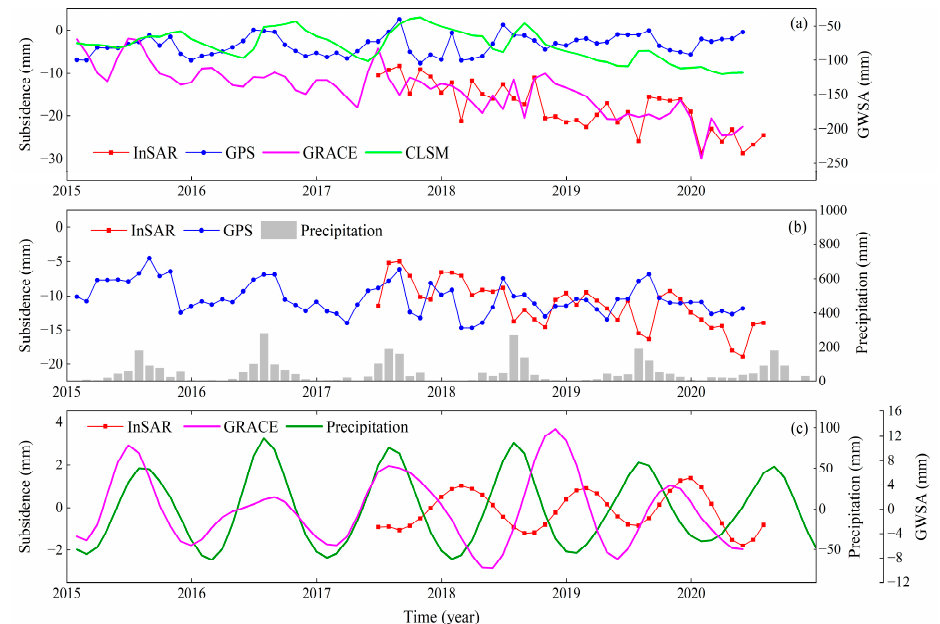
Figure 12. The relationship among GWSA , subsidence, and precipitation. ( a ) Comparison of average values in the Beijing Plain; ( b ) Comparison of average values in northern Beijing Plain; ( c ) Comparison of seasonal components.